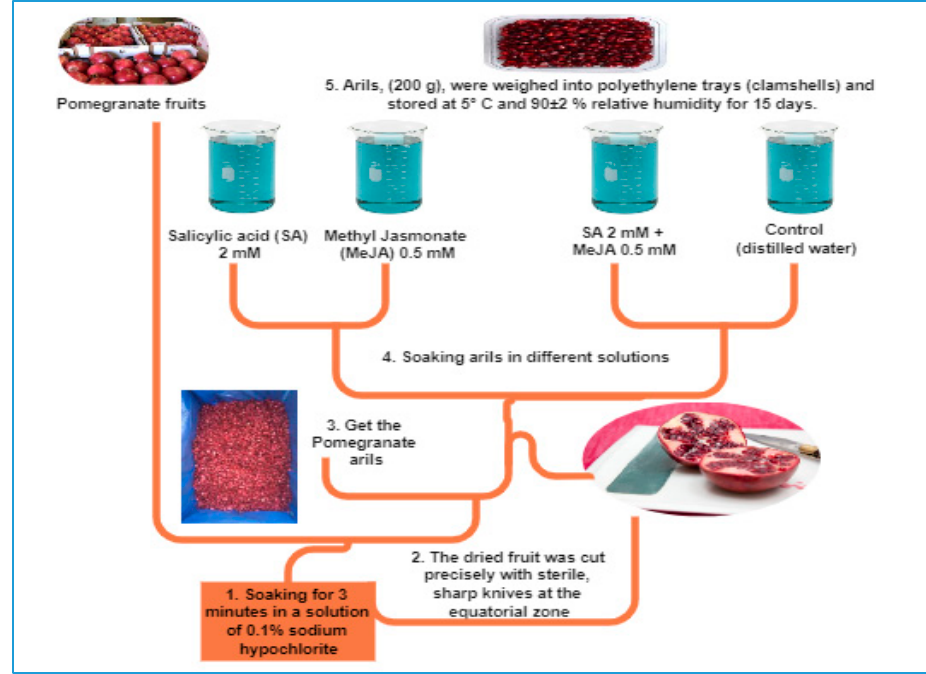
Figure 1. Preparation, treatments, and storage conditions of pomegranate arils.